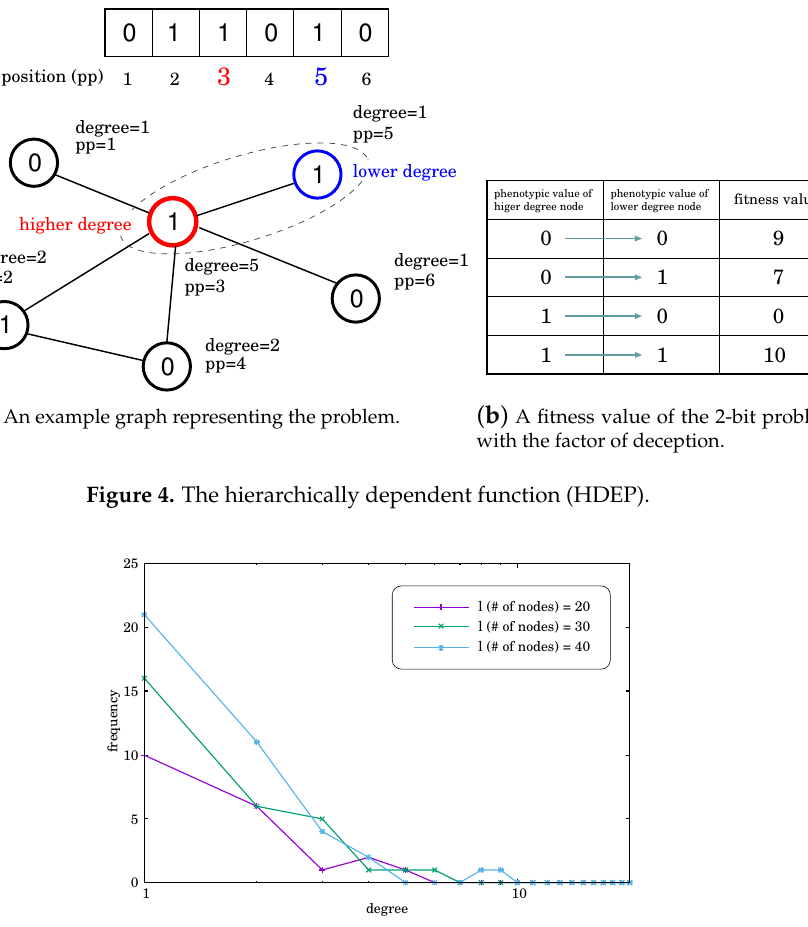
Figure 5. The degree distributions of three graphs used in the HDEP. The numbers of nodes in the three graphs, which are equivalent to the problem size, (cid:96) , are 20, 30, and 40. They are all power-law